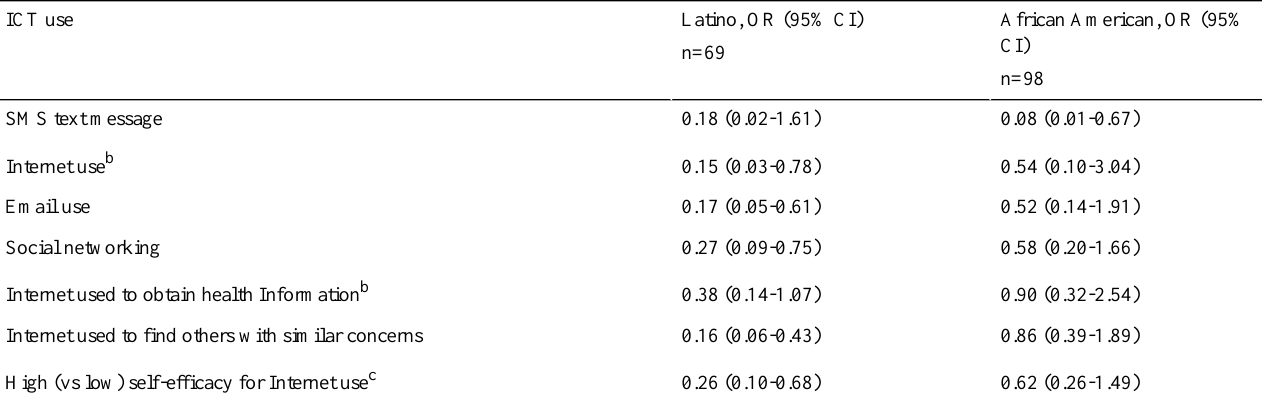
Table 2. Odds of using information and communication technology (ICT) by race/ethnicity. a